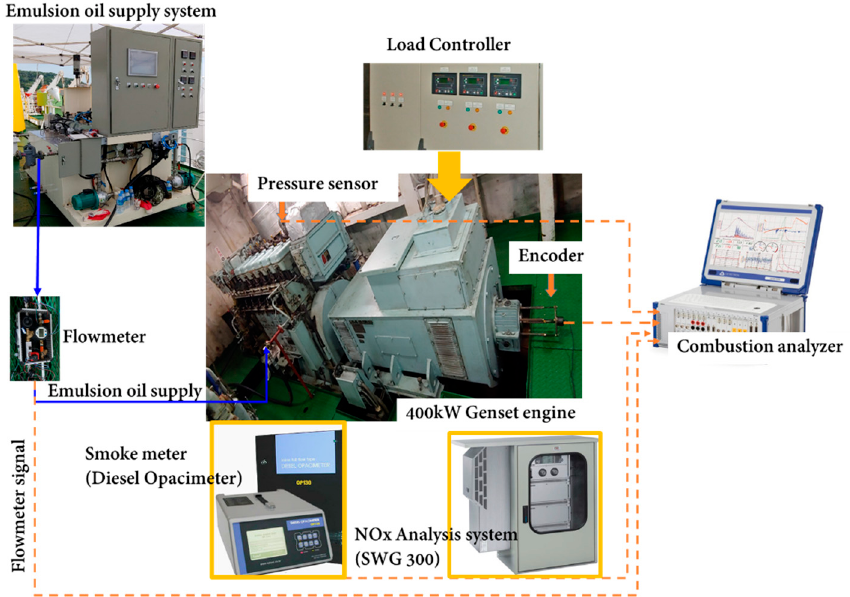
Figure 1. Schematic diagram of the marine engine and engine dynamometer.